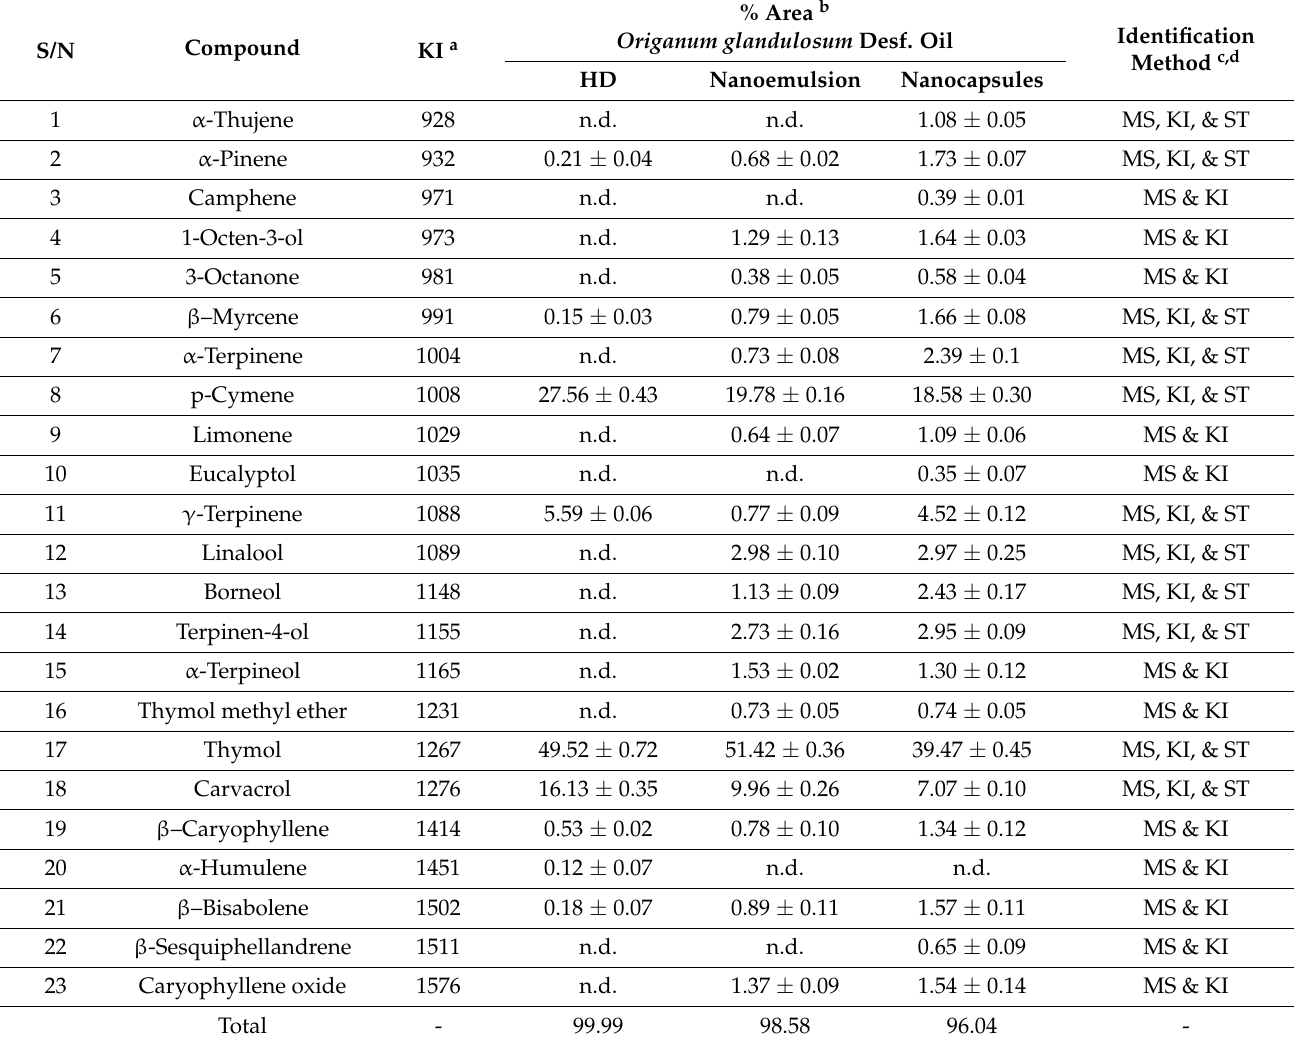
Table 1. Chemical constituents of O. glandulosum Desf. Oil and its